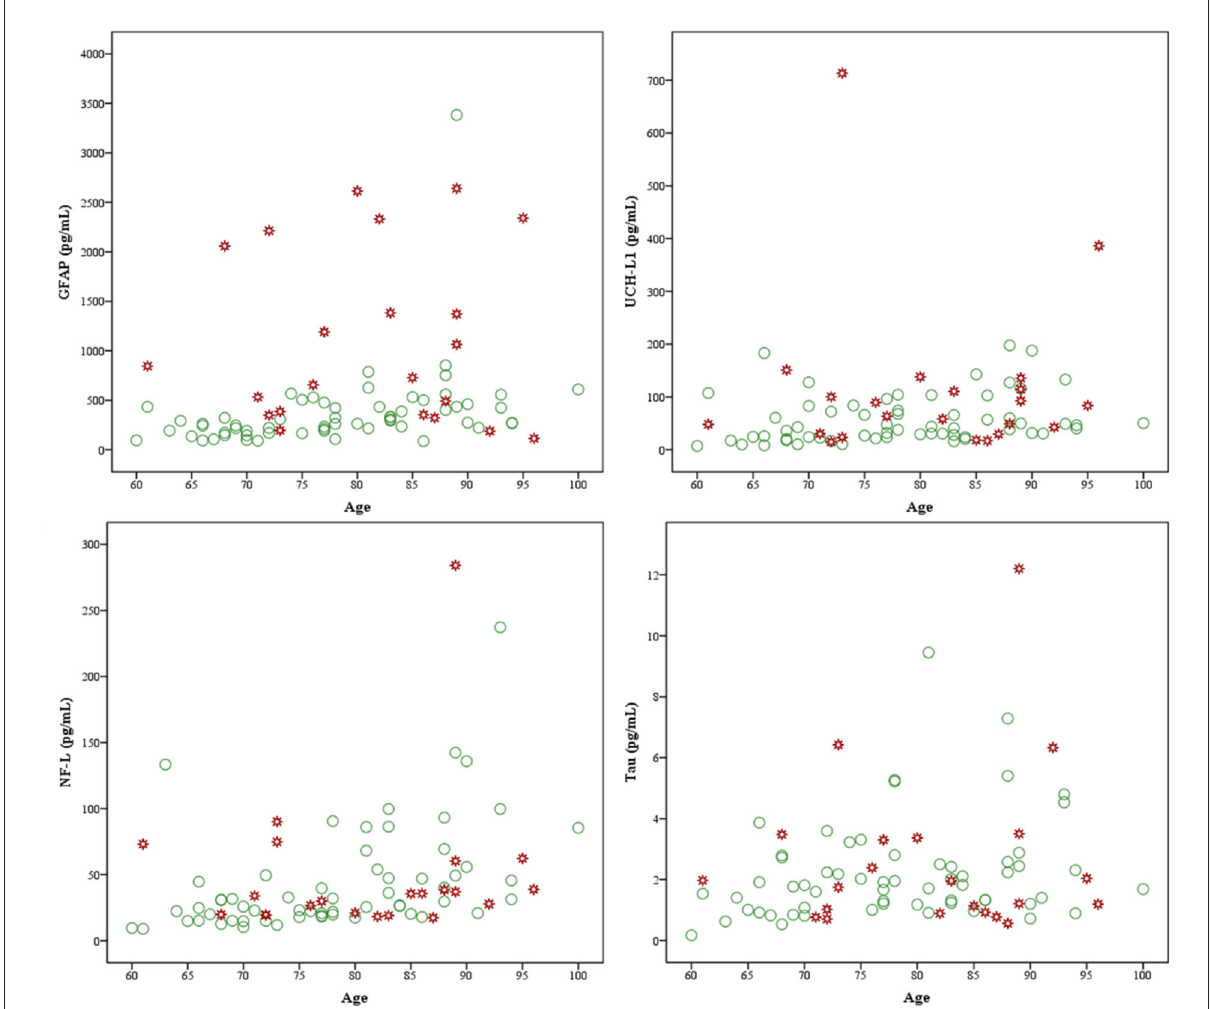
FIGURE3 Scatterplots of biomarkers and age by group. GFAP, glial fibrillary acidic protein, upper left; UCH-L1, ubiquitin C-terminal hydrolase-L1, upper right; NF-L, neurofilament light, lower left; and tau, lower right. Markers in green are subjects with normal head computed tomography (CT) ( n = 61) scans and markers in red are subjects with abnormal head CT scans ( n =